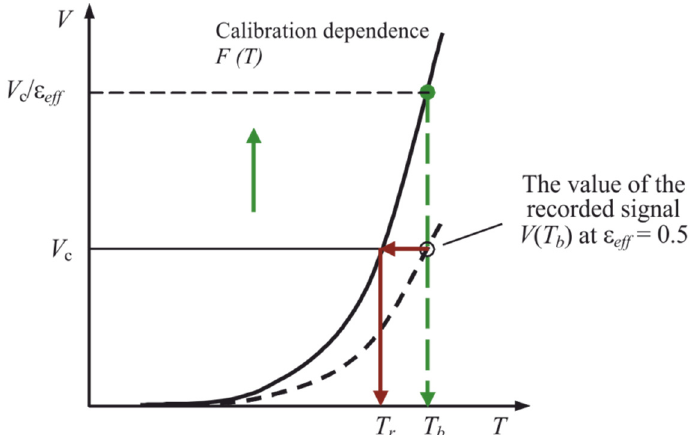
Figure 3. An approximate form of the calibration dependence F ( T ) (solid line) and the dependence of the recorded signal value on the body surface temperature T b at an effective thermal radiation coefficient ε eff = 0.5 (dashed line).